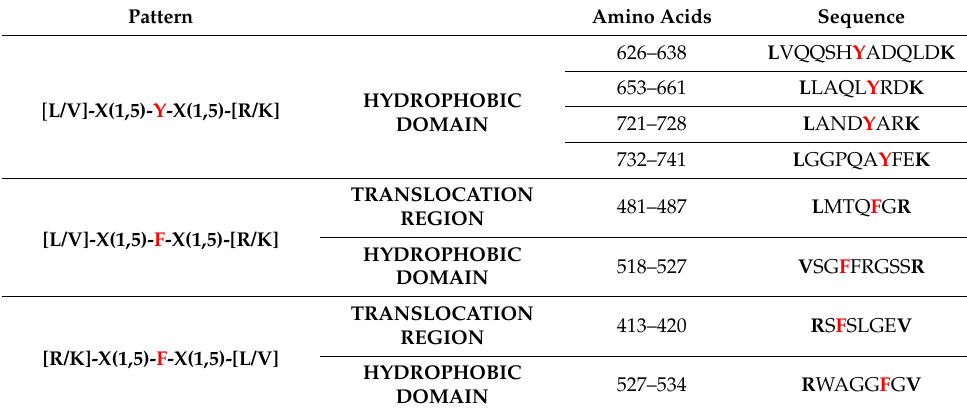
Table 1. Cholesterol-recognition motifs identified in the sequence of the membrane-interacting translocation region and hydrophobic domain of